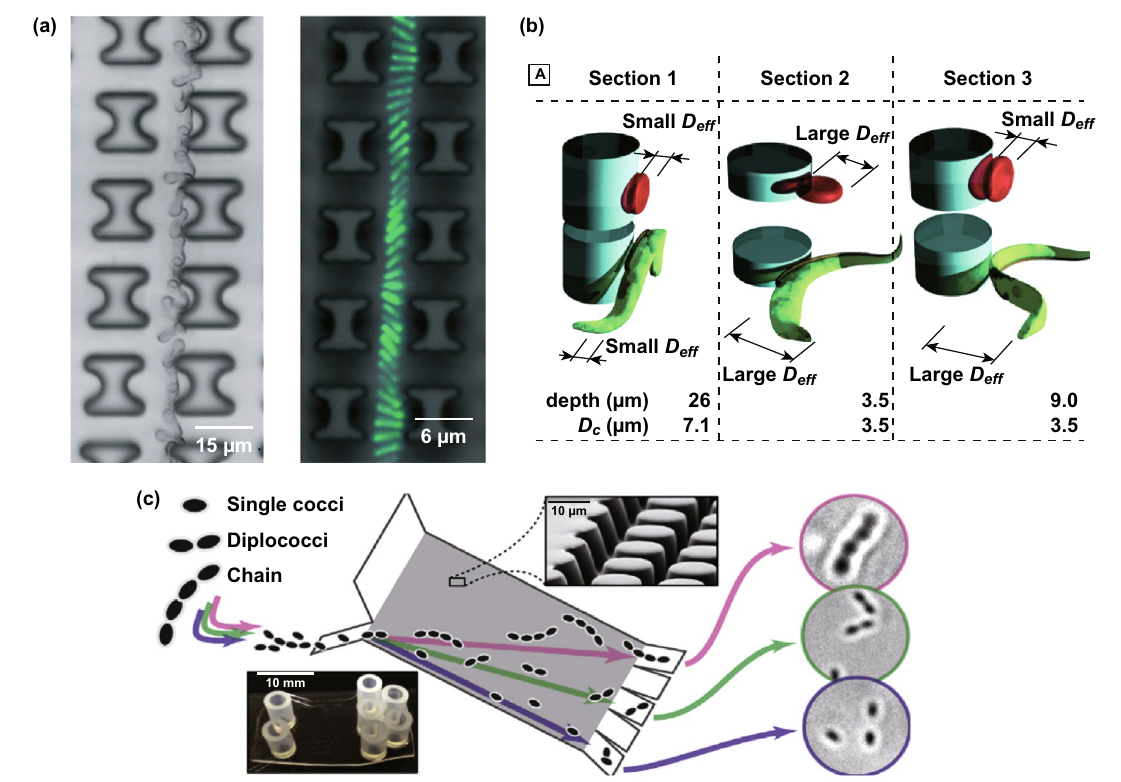
Fig. 12 Applications of morphology-based DLD separation. a The separation of red blood cells and rod-shaped bacteria in I-shaped DLD [19]. b The separation of red blood cells and trypanosomes based on the shape with the use of different device depths in a series configuration [17]. c The separation of bacterial pathogens based on the different bacterial chain lengths [81]. Figure panels reproduced from Ref. [19] with permis- sion from the Royal Society of Chemistry, copyright 2014, Ref. [17] with permission from the Royal Society of Chemistry, copyright 2016, Ref. [81] with permission from Elsevier, copyright 2018. (Color figure